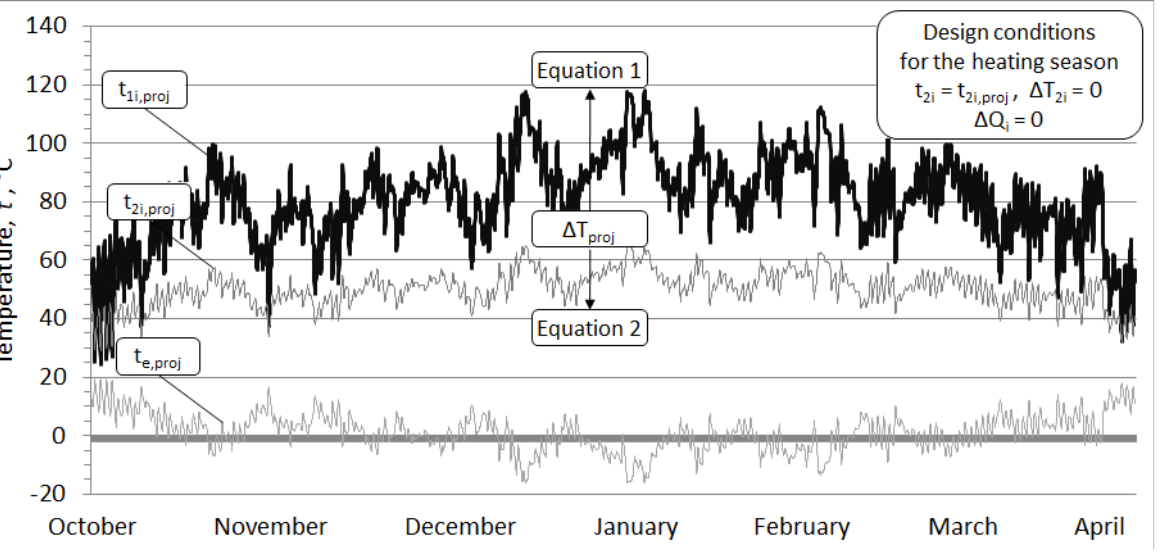
Figure 3 . Distribution of supply and return water temperatures under design conditions for the heating season.